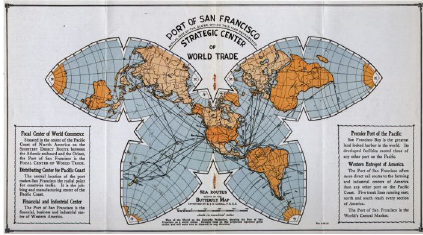
Fig. 14. Ship routes from San Francisco (source: GEO awesomeness website)